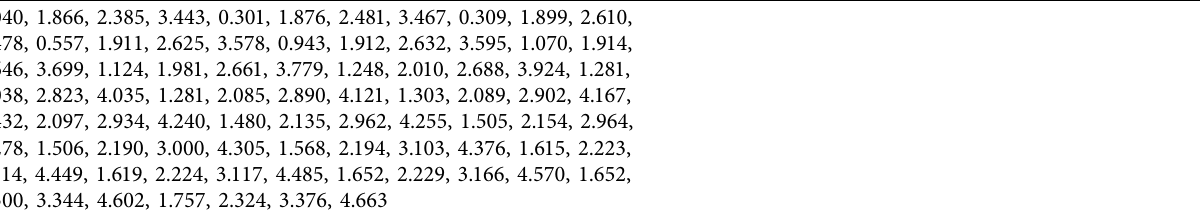
Table 5: The airplane windshield failure times data (in thousand hours).